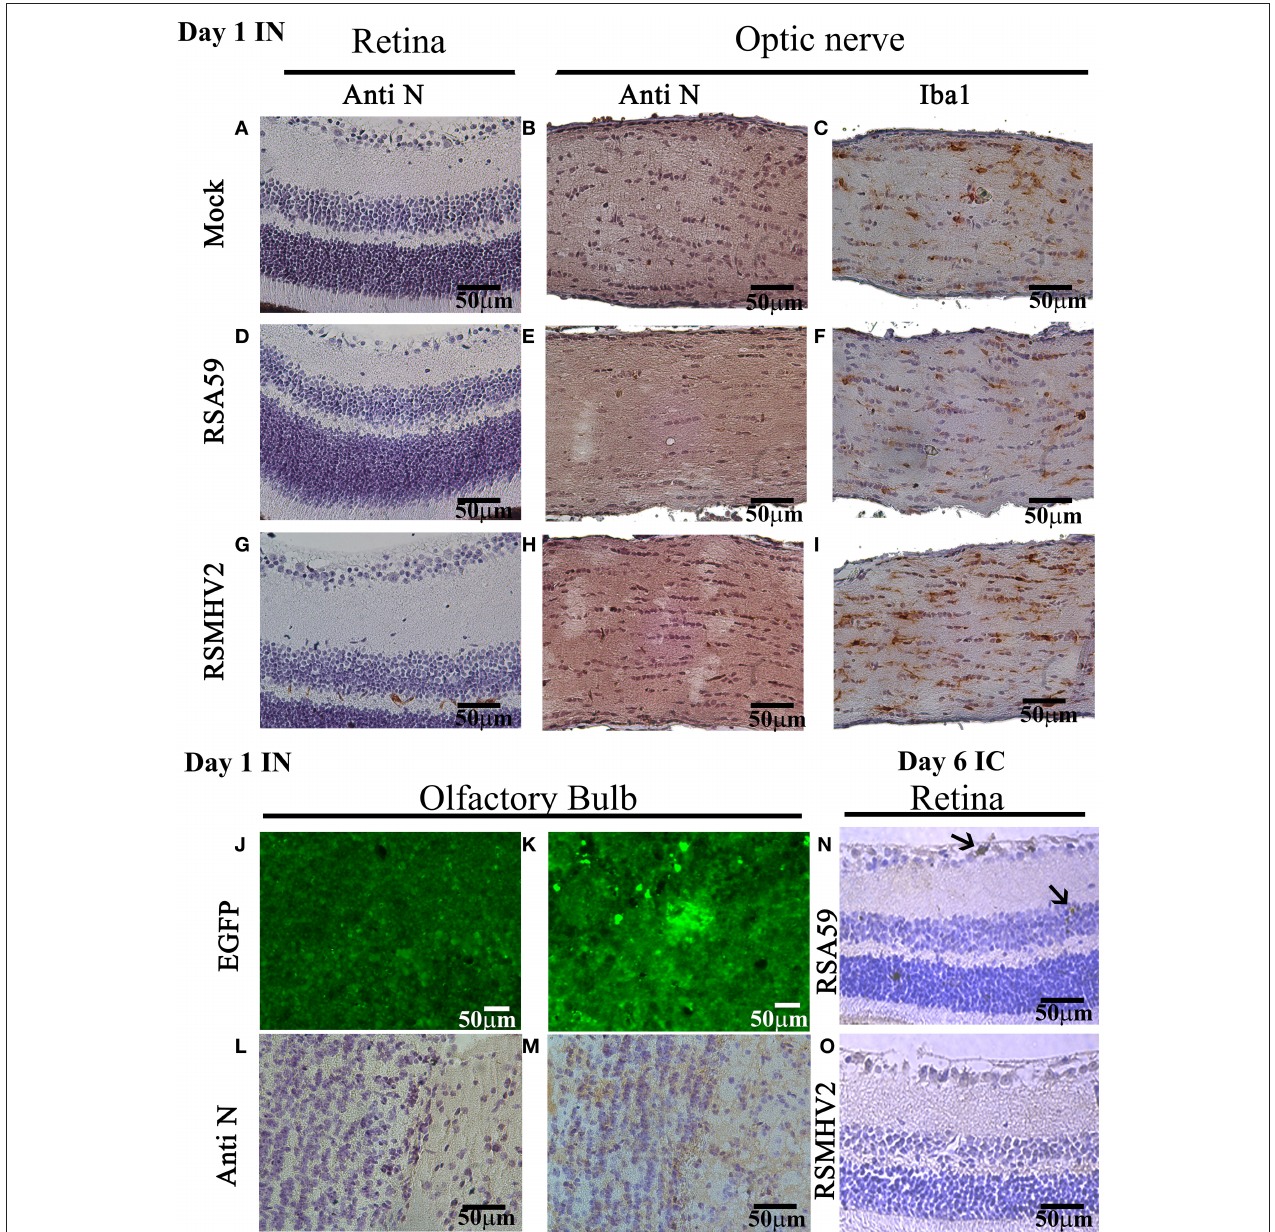
FIGURE 4 | RSA59 fails to accumulate acutely in retina and optic nerve. Representative 5 µ m thick sections of retina (upper left column) optic nerve (upper center and right columns) and olfactory bulb (lower panel) 1 day p.i. are shown from mock-infected mice (A–C,J,L ) and mice intranasally-infected with RSA59 (D–F,K,M) and RSMHV2 (G–I) (scale bar = 50 µ m). Retina sections 6 days p.i. from intracranially-infected RSA59 (N) and RSMHV2 (O) mice are also shown. Sections immunostained using anti-viral nucleocapsid antisera show no detectable viral antigen in retina or optic nerve on day 1 p.i. (A,B,D,E,G,H) , with some patchy brown stain in the olfactory bulb after intranasal viral inoculation with RSA59 (M) . EGFP fluorescence detected for virus presence in olfactory bulb sections shows high background in mock-infection mice (J) which prevented this from being quantified, but demonstrates some positive cells and clusters of cells in an RSA59 infected mouse (K) . Optic nerve sections stained with anti-Iba-1 antibody show the resting number and morphology of Iba-1 positive cells in mock-infected mice (C) , and similar resting microglial morphology across sections from RSA59 (F) and RSMHV2 (I) infected mice. Six days p.i., anti-viral nucleocapsid positive cells are present in the RGC layer (top arrow) and inner nuclear layer (bottom arrow) of the retina from a mouse intracranially-inoculated with RSA59 (N) , but not mice inoculated with RSMHV2 (O) .